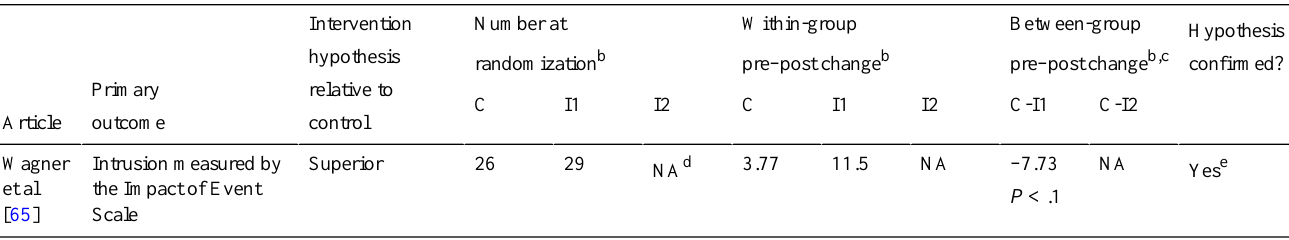
Table 5. Effects reported in therapy randomized controlled trials of acceptable quality of electronic symptom reporting a